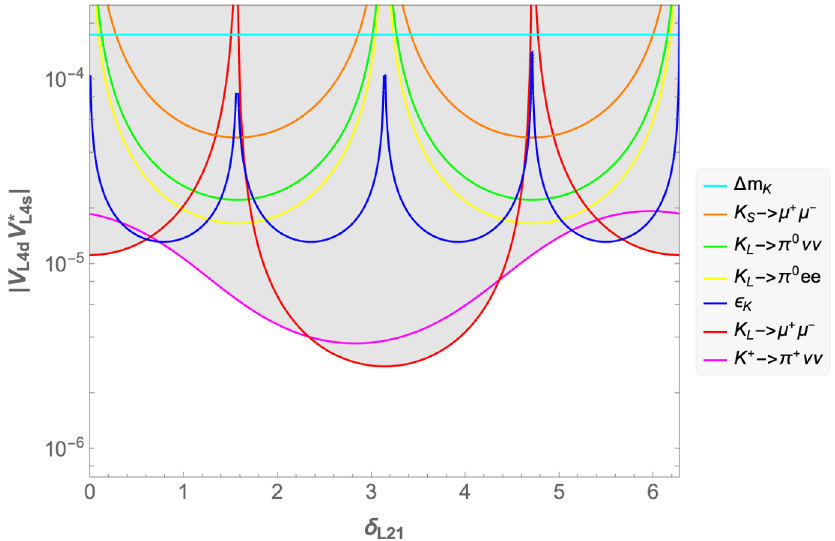
Figure 11 . Upper limits obtained from kaon decays and neutral kaon mixing on the product | V ∗ V L 4 d | of the elements of the mixing matrix V ( d ) L 4 s